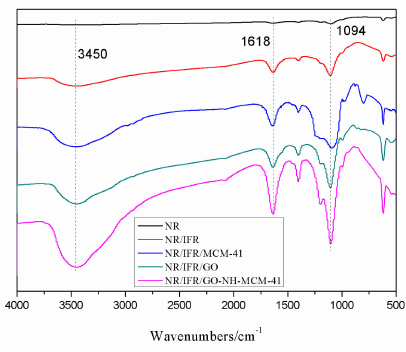
Figure 9. FTIR spectra of char residues of FRNR composites after